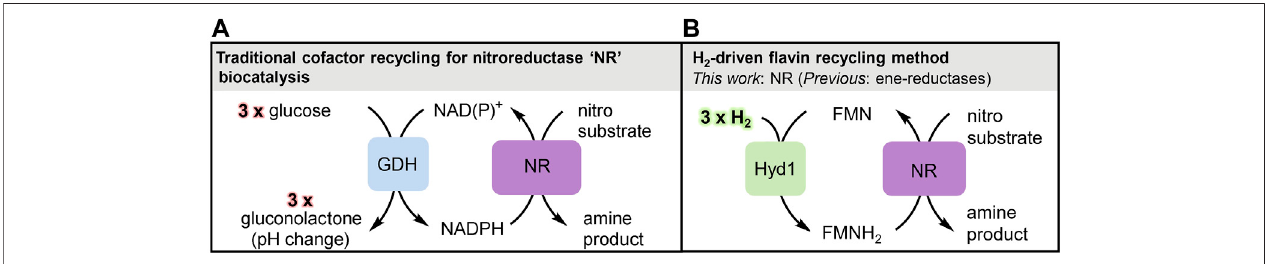
FIGURE 1 | Overview of biocatalytic cofactor recycling for nitro reductions. (A) Glucose/GDH method for NAD(P)H recycling, the commonplace industrial method for supplying reducing equivalents to nitroreductase (NR). The gluconolactone by-product causes a pH change thus requiring strong buffer concentrations